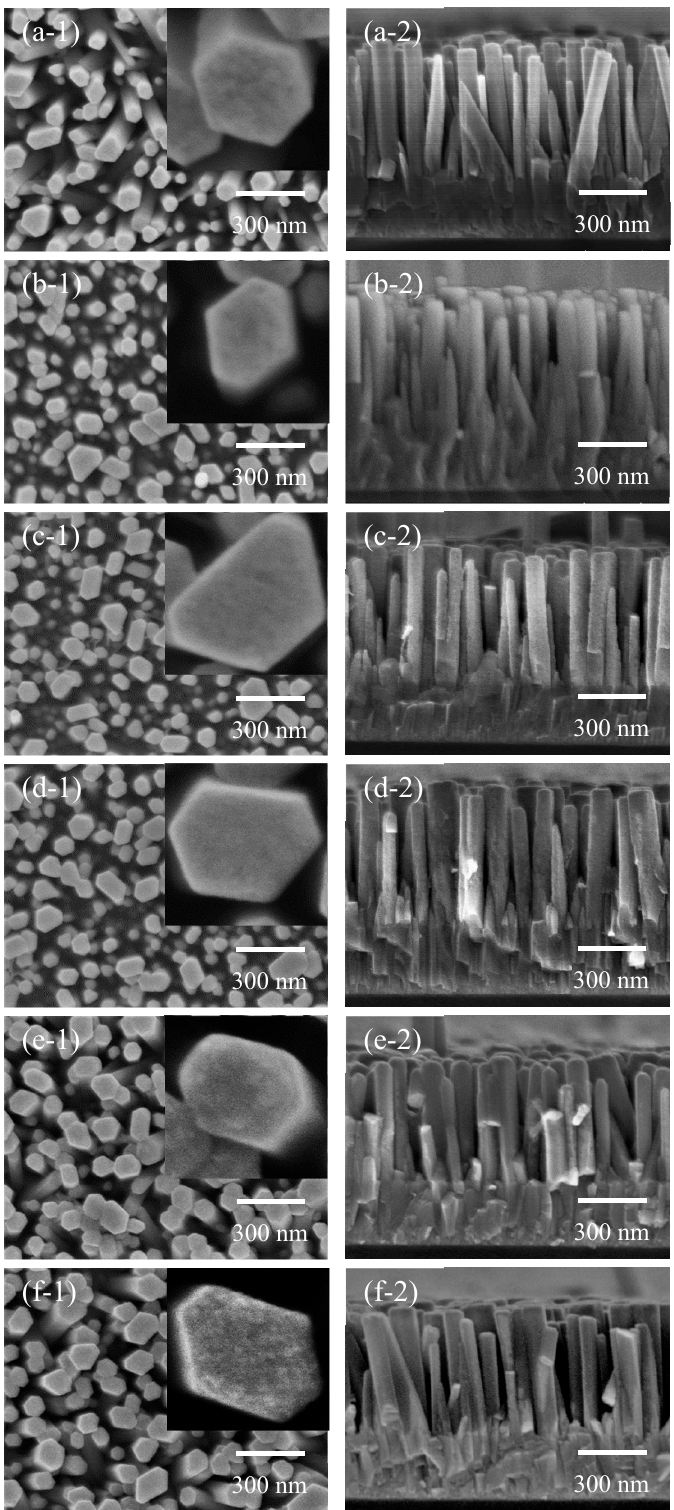
Figure 2. SEM images of the as-deposited ZnO nanorods ( a ) and ZnO nanorods coated with TiO 2 by mist chemical vapor deposition (CVD) for ( b ) 30 s; ( c ) 2 min; ( d ) 5 min; ( e ) 10 min; and ( f ) 15 min (( 1 ) top view and ( 2 ) cross section view).